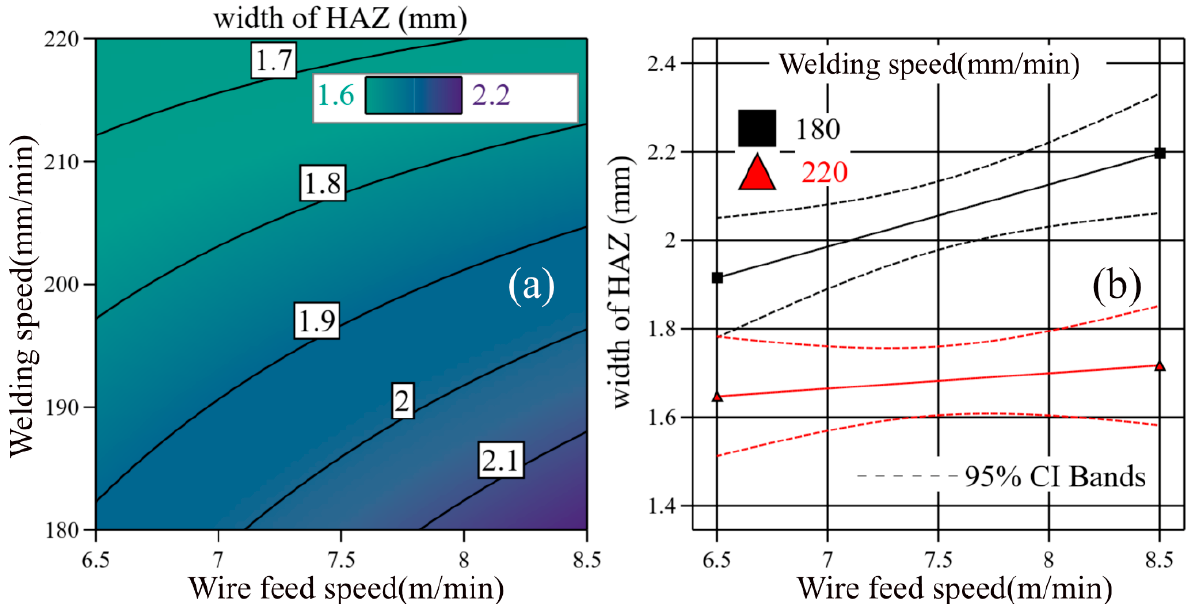
8 of 15 Figure 7. Height of filling passes in a couple of 12-millimeter-width grooves: ( a ) filling height ob- tained by the calculated models; ( b ) interaction of welding speed and wire feed speed on the filling height. Similarly, the width of the HAZs is given by Figure 8. The width of the HAZs ranged from around 1.6 mm to 2.2 mm. As the welding speed increased, there was less influence